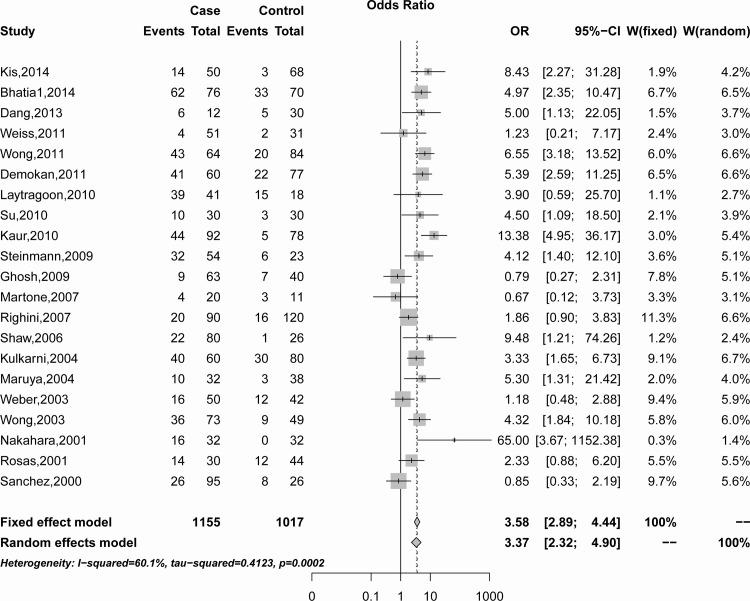
Summary estimates for p16INK4a promoter methylation frequency associated with HNSCC by meta-analysis.